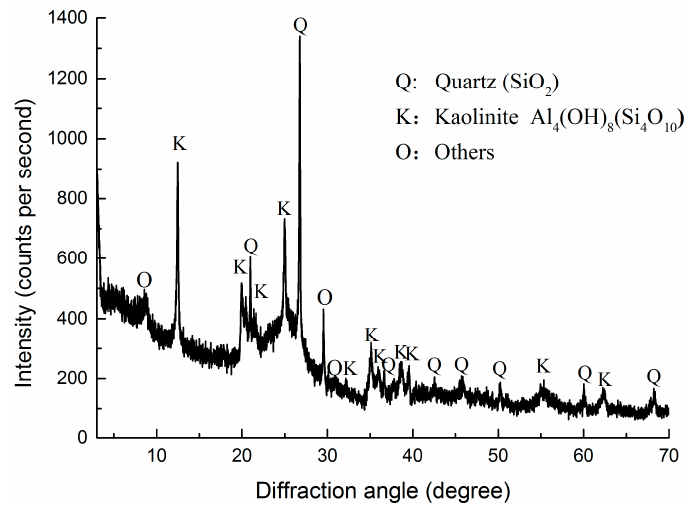
Figure 7. X-ray diffraction pattern of 8 1 coal sample.